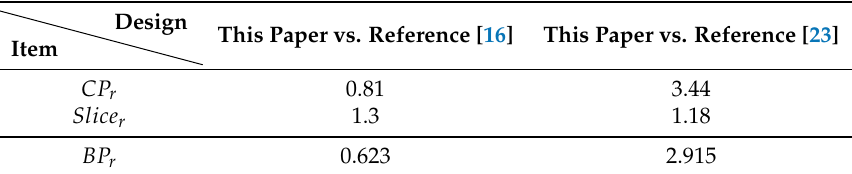
Table 5. Performance comparison after